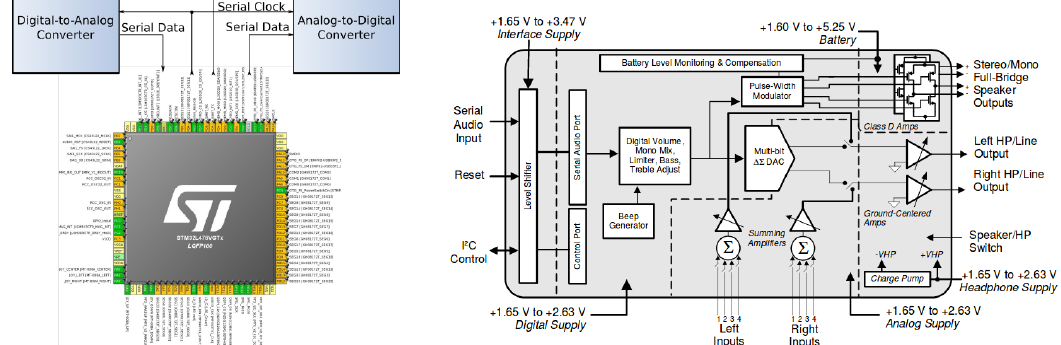
Figure 6. Simplified scheme of the SAI interface with the SoC pinout and the functional diagram of audio DAC.